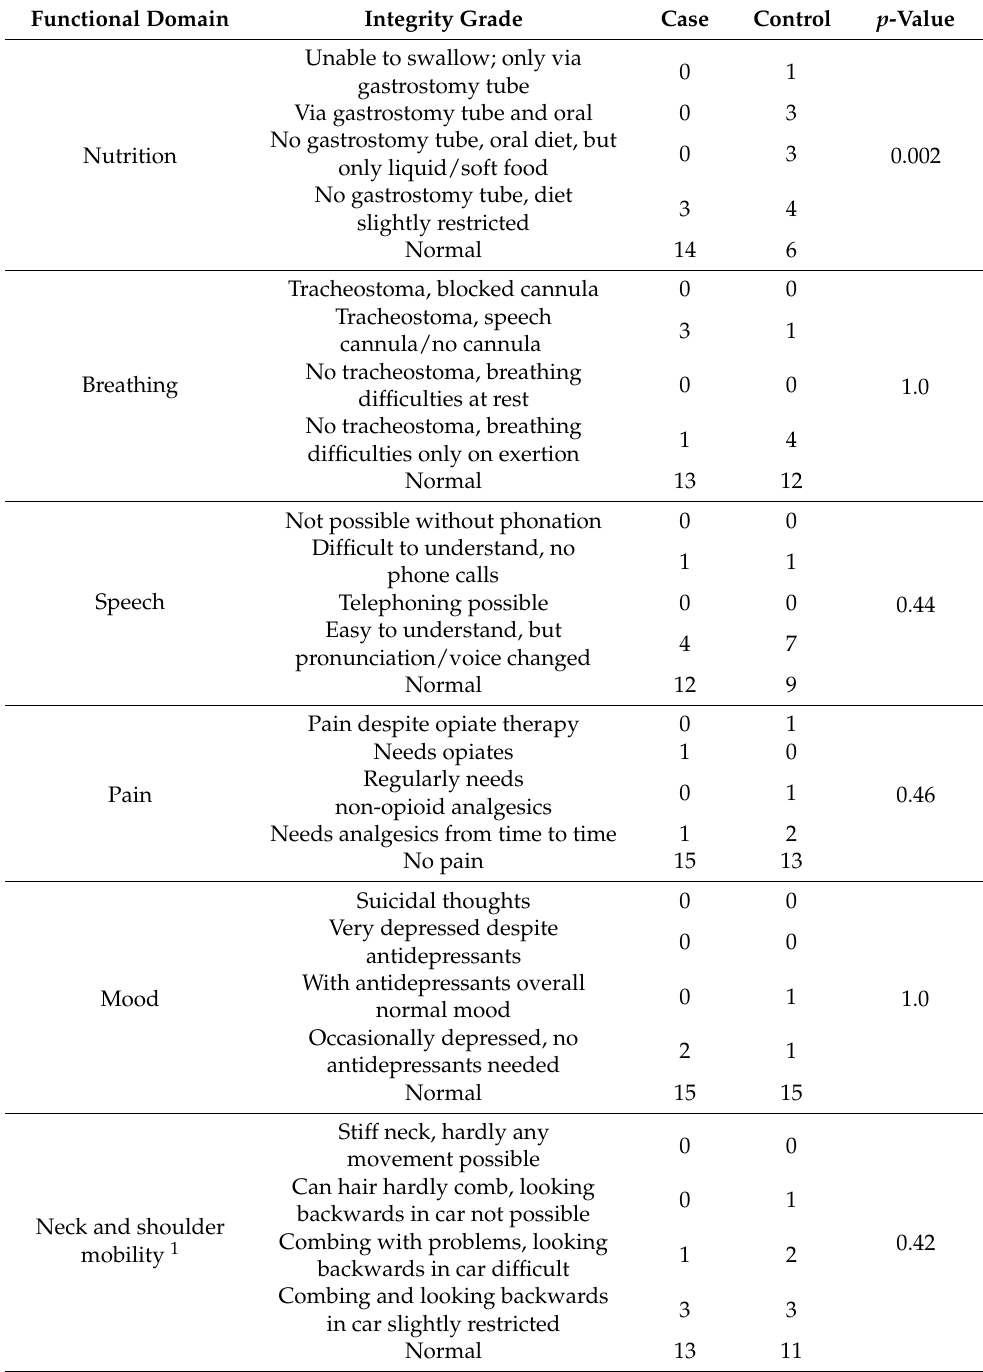
Table 4. Head and neck functional integrity scale outcome of surgically treated patients with treatment de-escalation (cases) and patients with primary RT ± ST